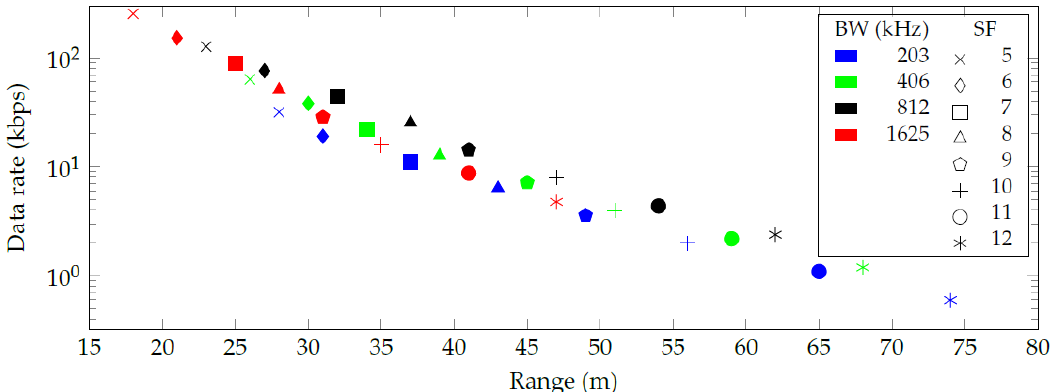
Figure 3. Communication range and data rate for every combination of spreading factor (SF) and bandwidth (BW) in an indoor environment.